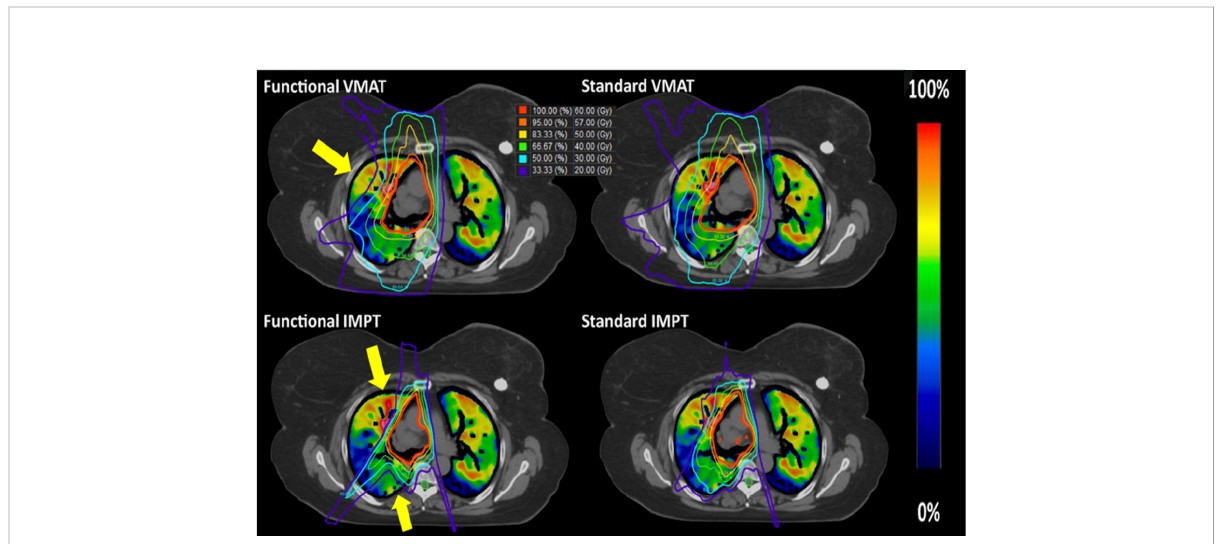
FIGURE 3 Examples of the standard and functional plans with VMAT (top) and three- fi eld IMPT (bottom) techniques. The yellow arrow indicates where the most functional sparing occurs for this patient. Reproduced from reference (90) with permission from Wiley, copyright